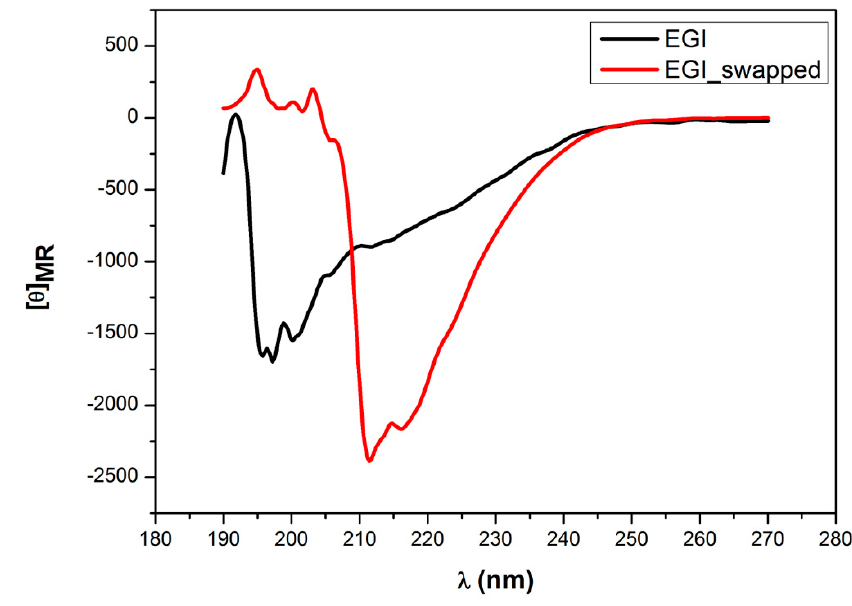
Figure 6. The CD spectroscopy measurement of EGI and EGI_swapped enzymes after 1 h denaturation at 95 ◦ C. Through Circular Dichroism, the change in structures of EGI and EGI_swapped was carefully traced between 195 nm and 230 nm after 1-h heat denaturation at 95 ◦ C and 3-h incubation at room temperature. The CD measurement was performed at room temperature with samples prepared in 20 mM sodium acetate buffer (pH 4.7) that was corrected for the backgrounds. For EGI_swapped, the peaks at 211 nm and 216 nm are indicated. All results are displayed in mean residue ellipticity ([ θ